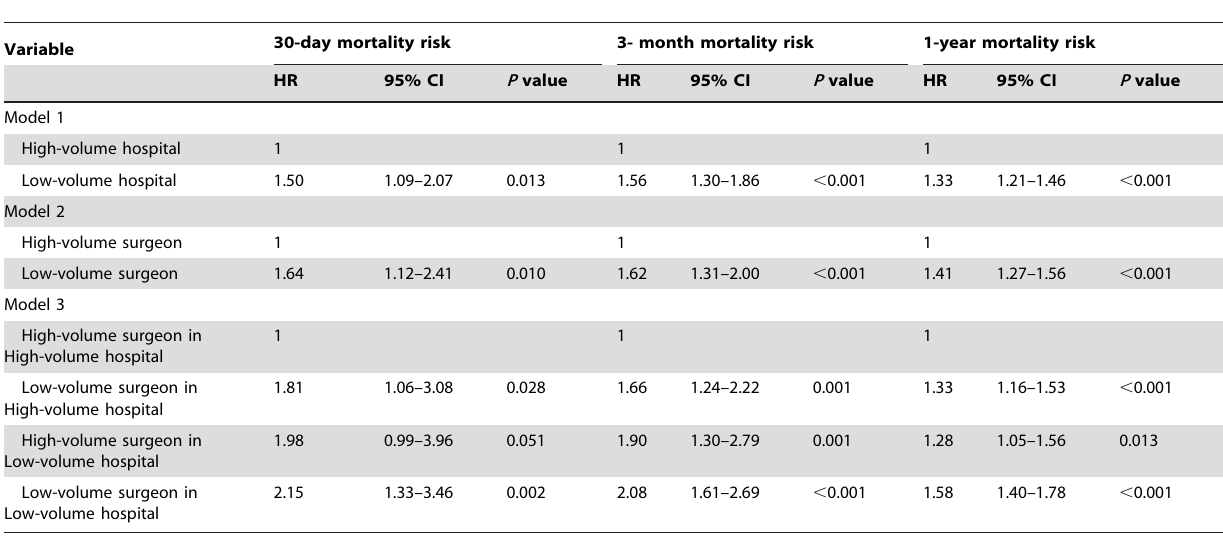
Table 2. The adjusted hazard ratios of provider categories in different regression